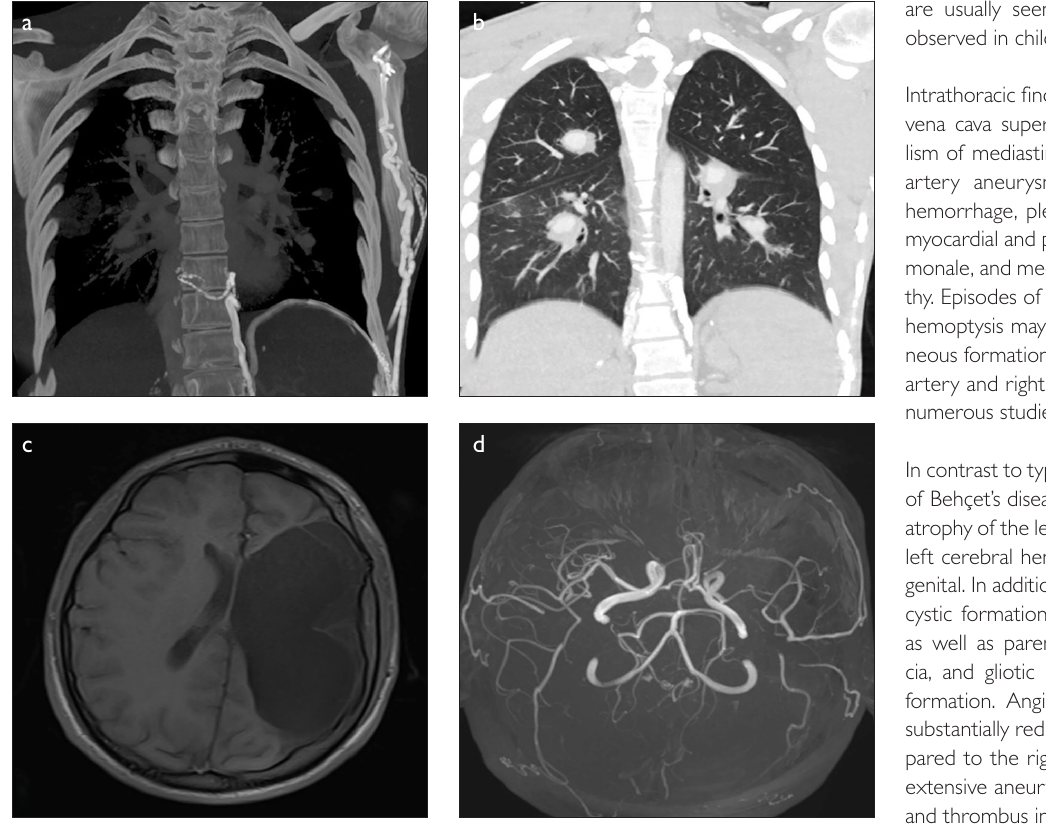
Figure 1. a-d. Coronal MPR MIP (a) and coronal MPR parenchymal window (b), chest CTA, T1 TSE transvers (c), and TOF 3D multislap MIP transverse brain MRI